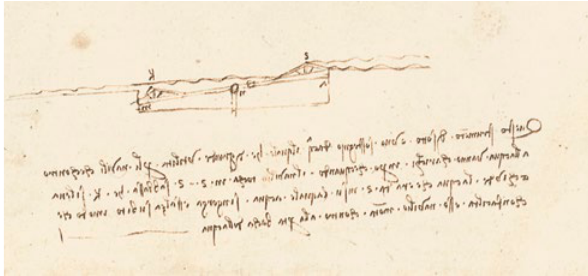
Figure 28. C.A., fol. 127v, detail: rocker water